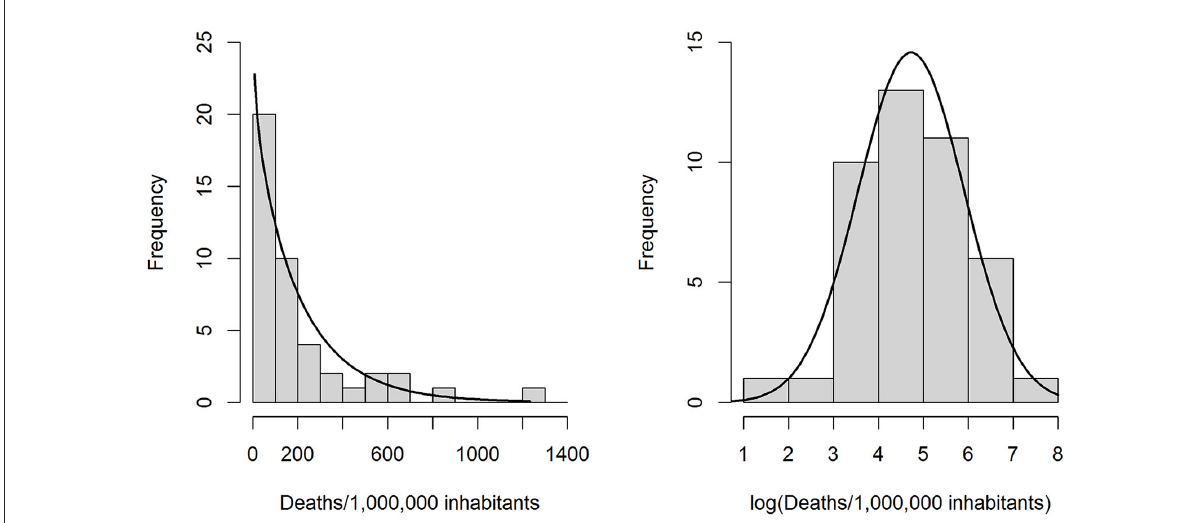
FIGURE1 Left: Observed distribution of the outcome variable “COVID-19 related deaths per 1 million inhabitants” and a gamma distribution (rate = 0.00438, shape = 0.9270) fitted through maximum likelihood estimation. Right: Observed distribution of the log-transformed outcome variable, with a best-fit normal